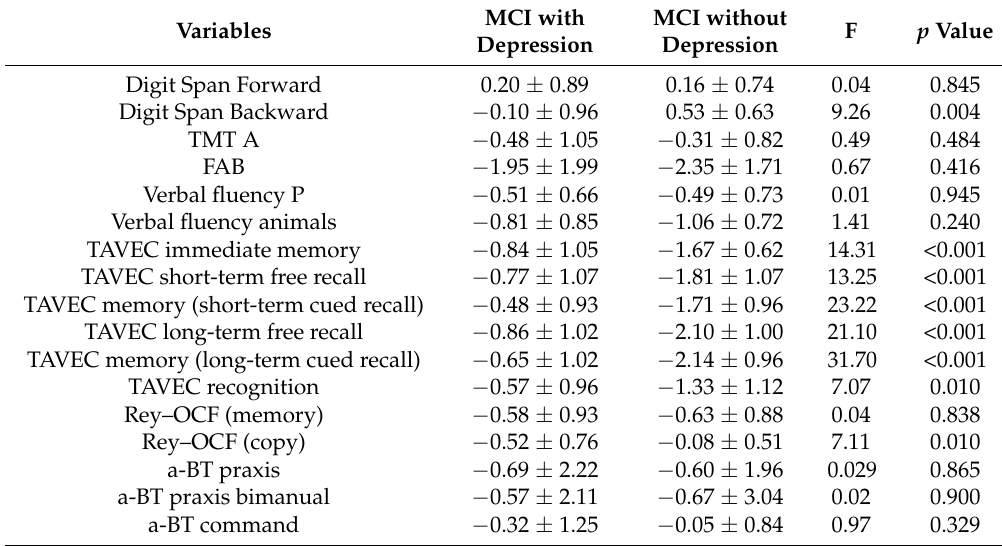
Table 2. Neuropsychological z -scores for the two groups studied: MCI with depression and MCI without depression. Data are presented in the following form: mean ± standard deviation. Group differences were performed by analysis of variance (ANOVA) with post hoc analysis (Bonferroni), and the significance level was set at 0.001. The degrees of freedom for F values are (1, 95). MCI = mild cognitive impairment; TMT = Trail Making Test; FAB = Frontal Assessment Battery; TAVEC = Test